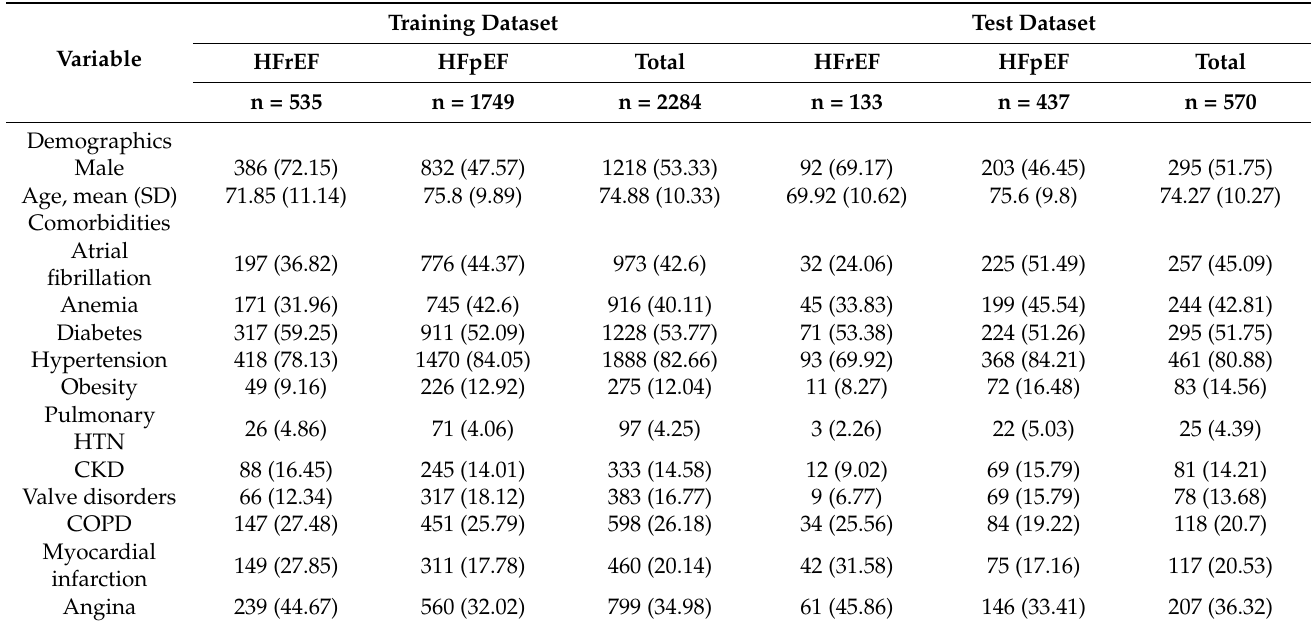
Table 1. Demographics and chronic diseases